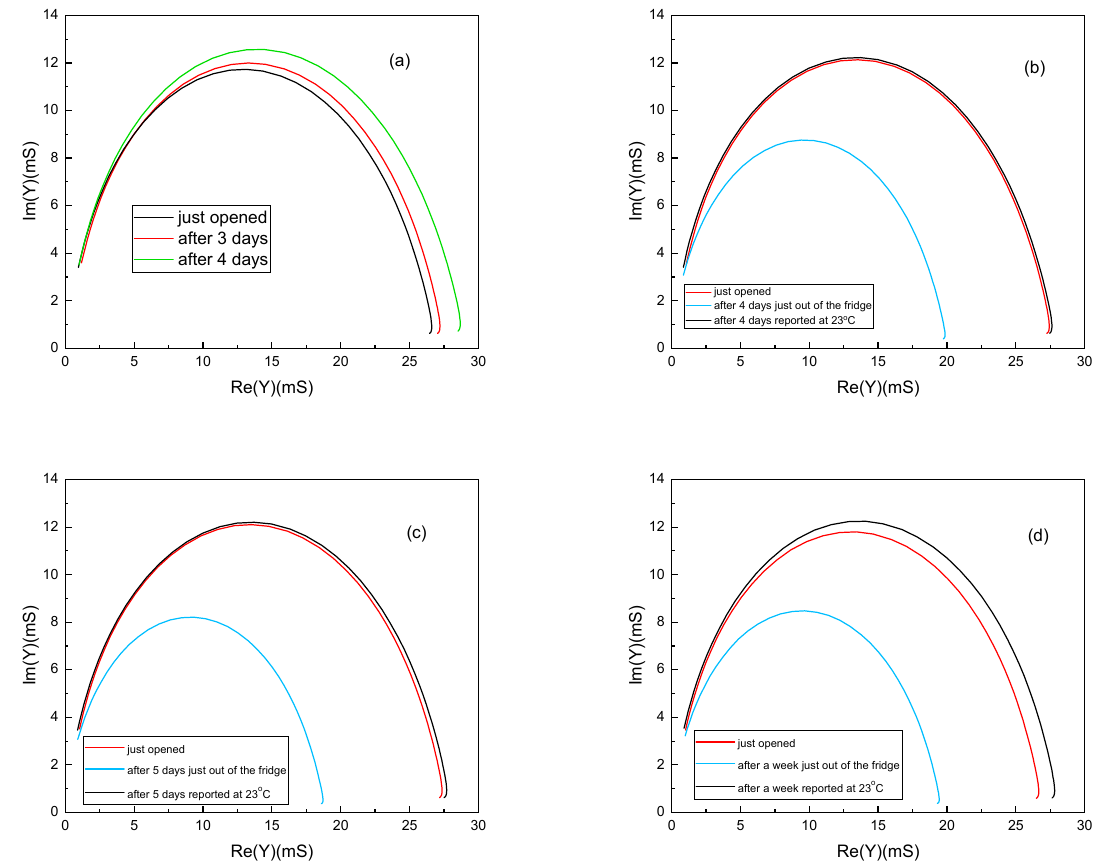
Figure 12. ( a ) variation of the Nyquist diagram of a freshly opened milk sample, after three and four days of storage at room temperature; ( b ) variation of the Nyquist diagram of a freshly opened milk sample, after 4 days of storage in the fridge as soon as it comes out of the fridge and brought back to room temperature; ( c ) the same as ( b ) but after 5 days of storage; ( d ) the same as ( b , c ) but after a week of storage.